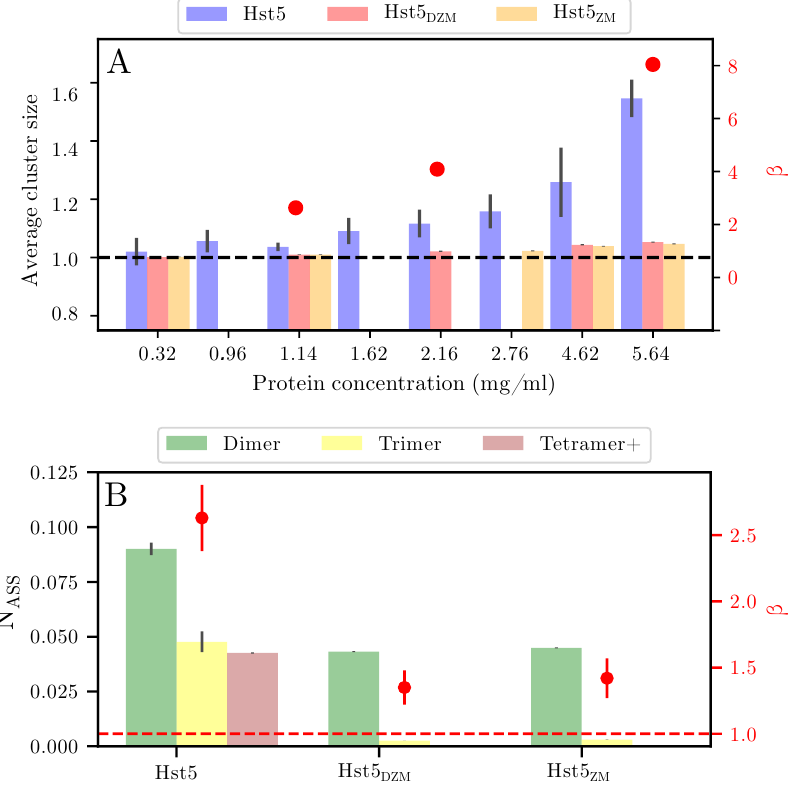
Figure 9. Distribution of oligomers determined by computer simulation for Hst5 and variants . ( A ) Average cluster size for Hst5 and variants as indicated determined by computer simulation. Shown for increasing concentrations of the respective protein.The scatter points correspond to the β values determined for Hst5 from SAXS (red y-axis). ( B ) Distribution of the formed clusters obtained by computer simulation, the bar chart corresponds to the determined N ass . Tetramer + corresponds to tetrameric and higher oligomers. The scatter points correspond to the β values determined from SAXS (red y-axis, as shown in Figure 7). The red and black dashed lines represents a β value of 1, i.e., a monomeric